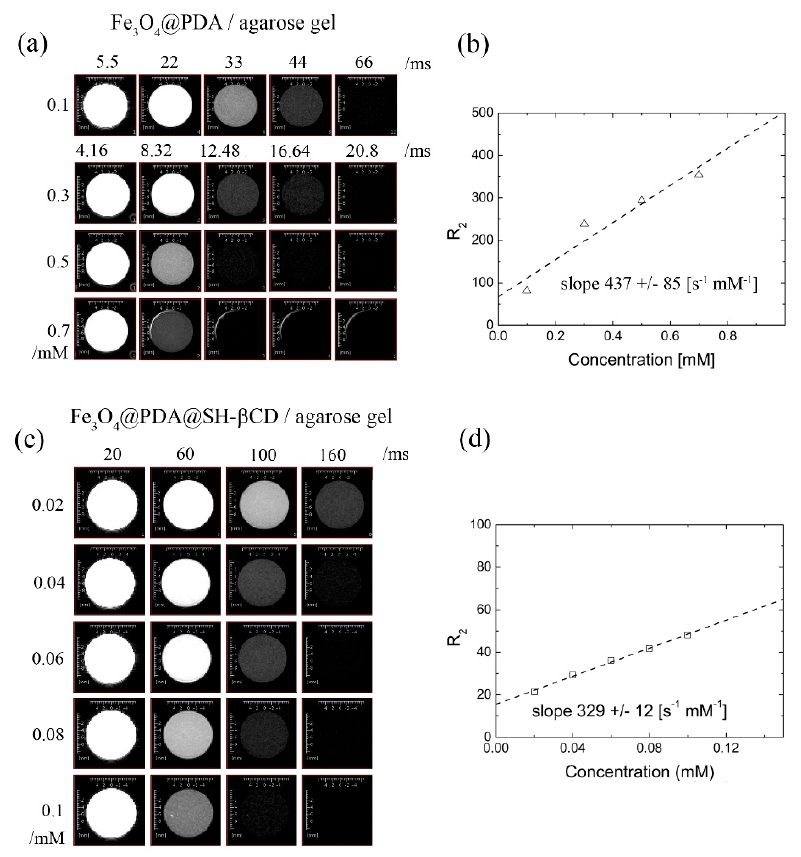
Figure 5. ( a ) The T 2 weighted MRI images for selected spin echo times obtained for Fe 3 O 4 @PDA in 2 wt % agarose gel; ( b ) Relaxation rates R 2 as well as relaxivity obtained from MRI experiment for Fe 3 O 4 @PDA in agarose gel 2 wt %; ( c ) The T 2 -weighted MRI images for selected spin echo times